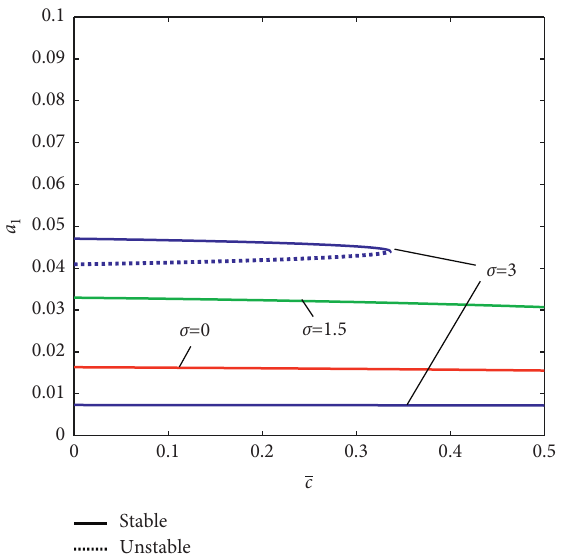
Figure 13: Amplitude versus damping coefficient with different ply angles (L/d � 10, σ � 2, case I).